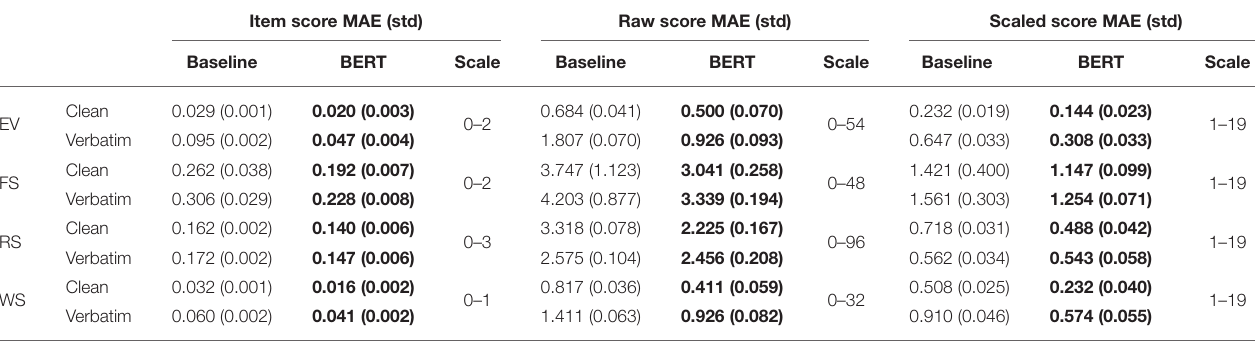
TABLE 4 | Mean (and standard deviation) of mean absolute error (MAE) for score estimation at the item score, raw score, and scaled score